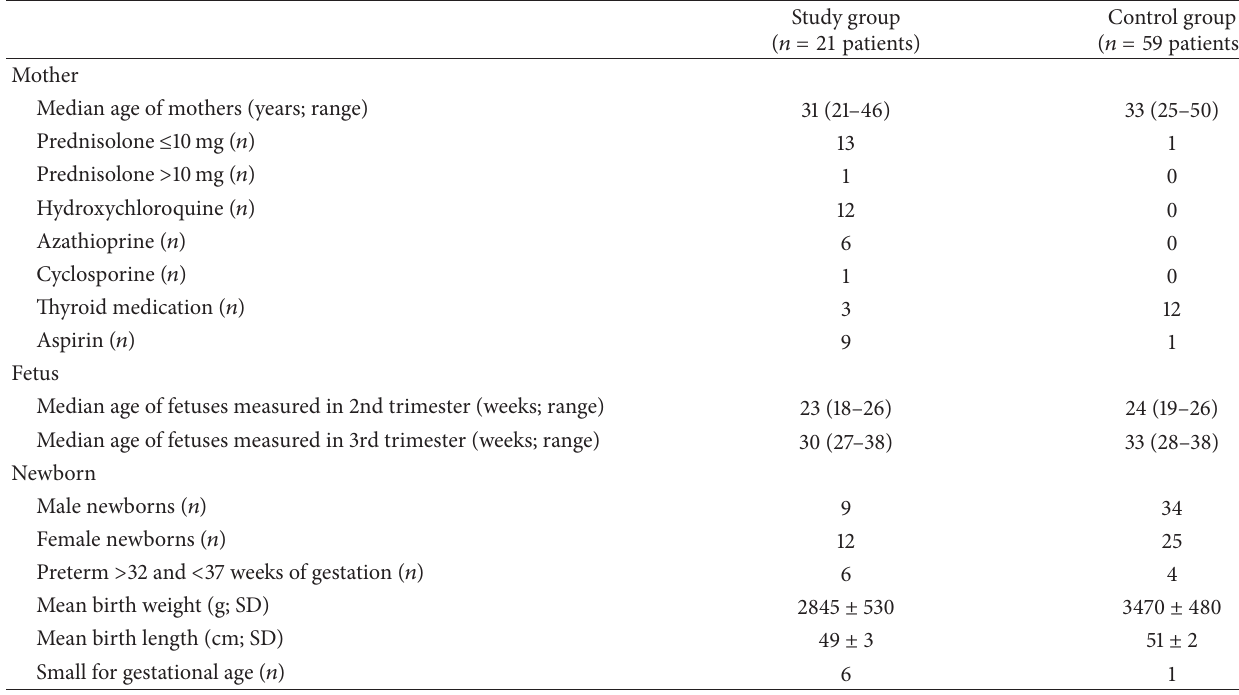
Table 1: Baseline characteristics of the mothers, fetuses, and newborns.